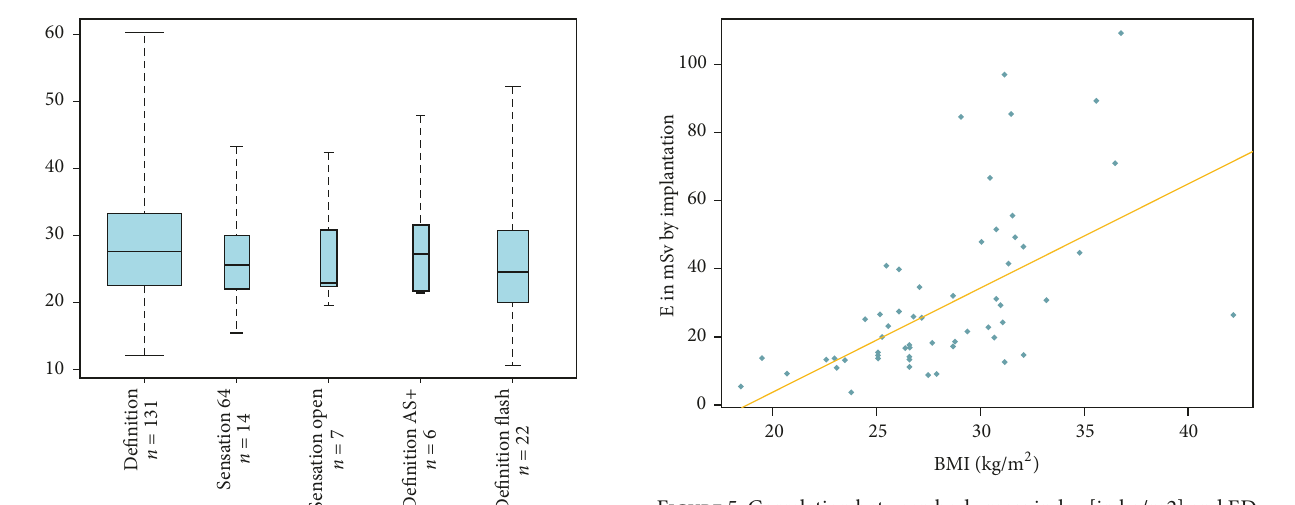
Figure 5: Correlation between body mass index [in kg/m2] and ED [in mSv] from the EVAR procedure.